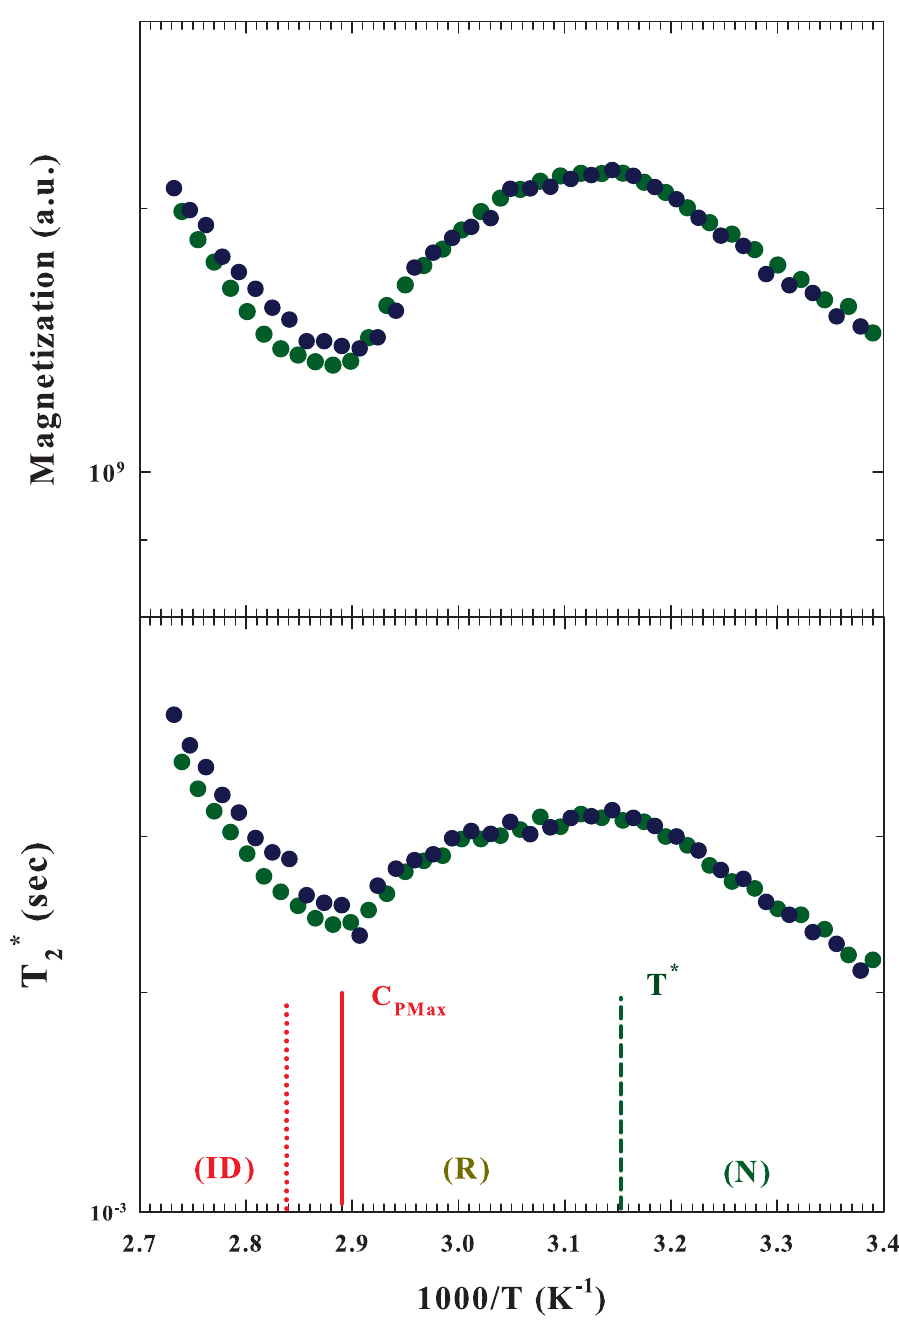
Figure 4. The Arrhenius plot, of the Magnetization ( M 0 upper panel) and the apparent spin-spin relaxation time ( T ∗ bottom) measured for h = 0.3 by using two different samples. For both the 2 quantities the temperature range is the same (295–366 K). M 0 evolves from 1.6 to 1.16 · 10 − 9 (a.u.), whereas T ∗ from 2.5 to 1.5 · 10 − 3 2